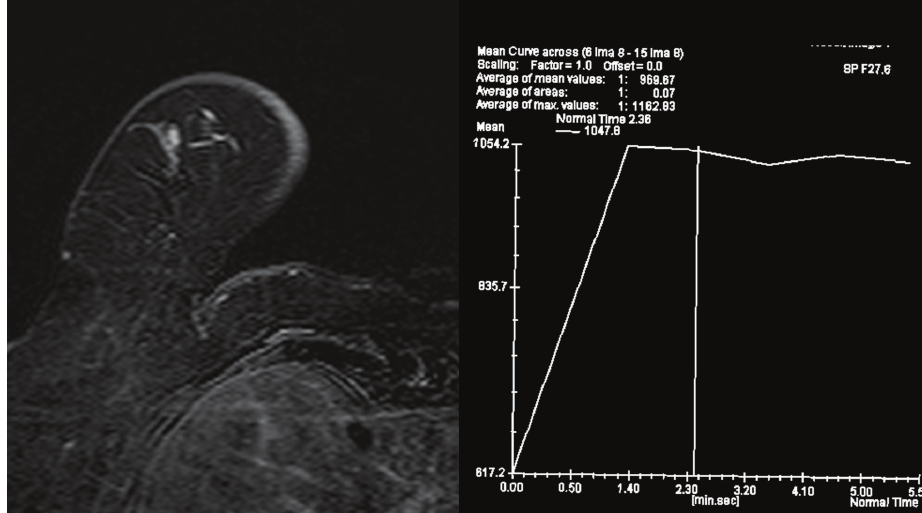
Figure 2: On dynamic series, mass with smooth and lobular margin with an adjacent vessel is observed. Time intensity curve shows rapid washin and minimal